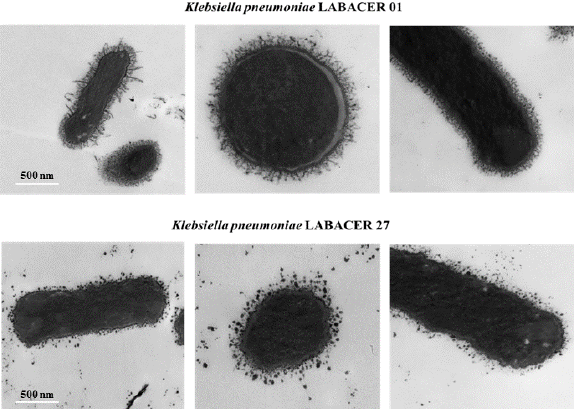
Figure 11. Transmission electron microscopy analysis of the KPC-2-producing hypermucoviscous ST25 Klebsiella pneumoniae strains LABACER 01 and LABACER